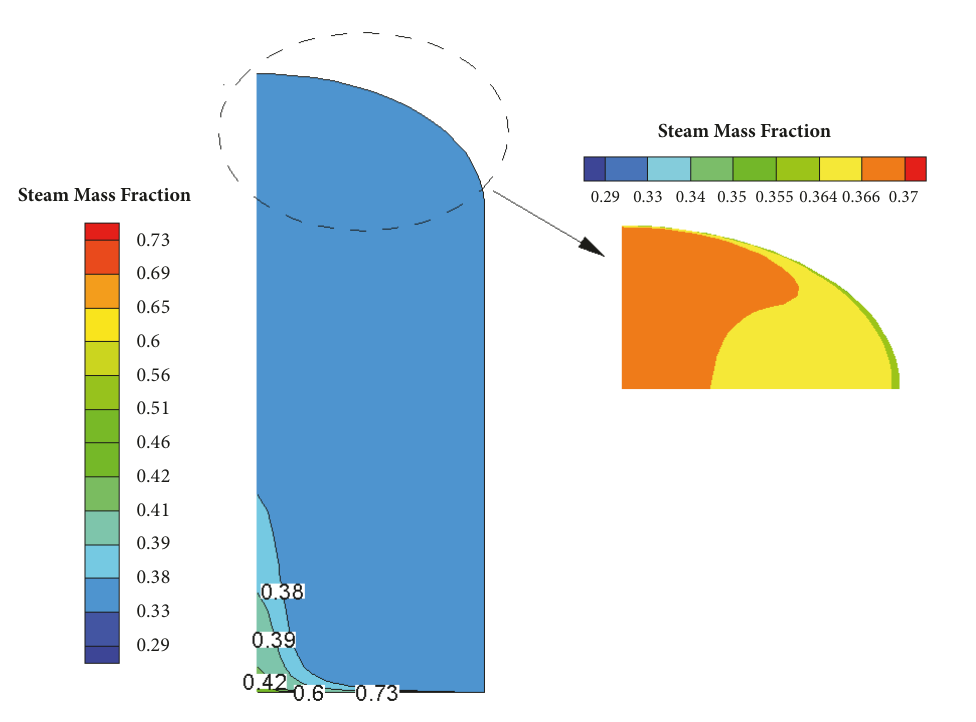
Figure 14: Steam mass fraction contour in the AP1000 containment.